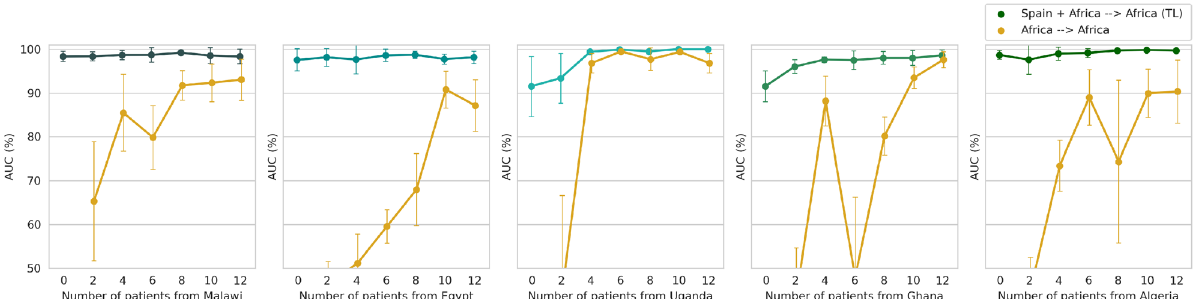
Figure 4. The evaluation of the model after being trained in Spain with all available samples and fine-tuned using a different number of patients from each African centre, as compared to the performance of the model directly trained with the African US images.